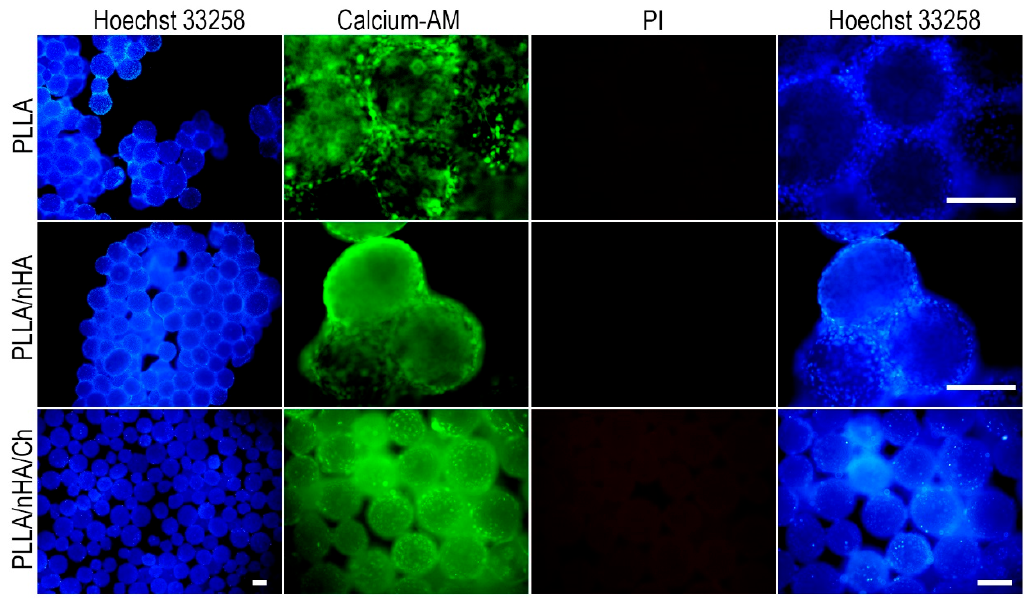
Figure 7. Live/dead staining of MC3T3-E1 cells of P7 passage cultured for 120 h on the surface of the three microcarriers. Scale: 250 μ m.